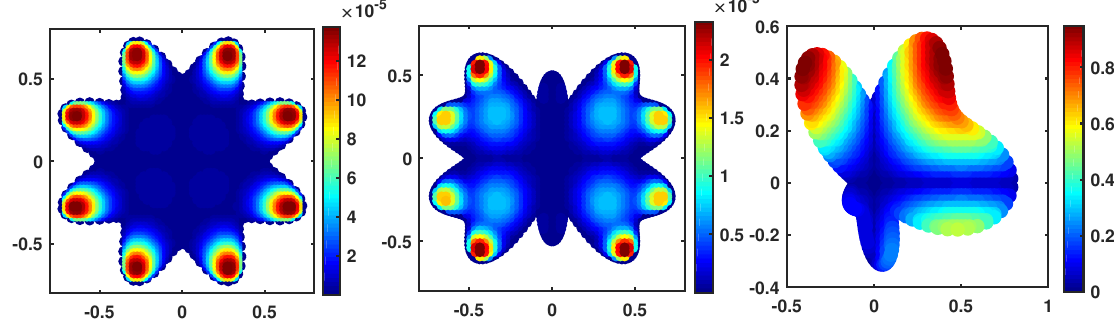
Figure 4. E max –error function at T = 1 with τ = 0.1 in Ω 1 , Ω 2 , and Ω 3 for Example